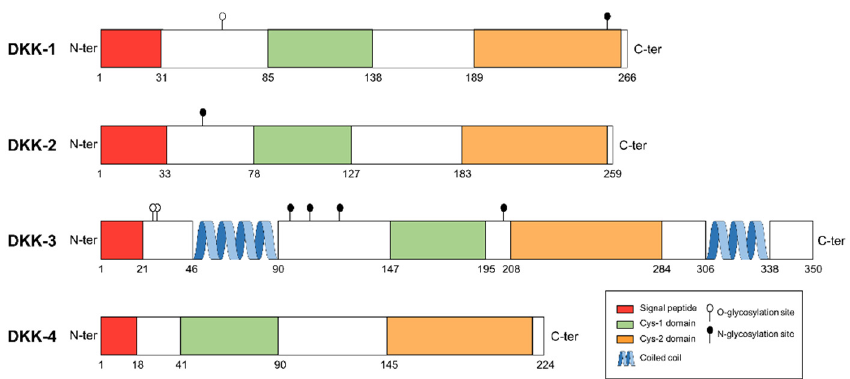
Figure 1. Domain structure of human DKK protein family. Cysteine-rich domain 1 (Cys1) and Cys2 domains are shared by the four members of DKK family. Signal peptide, coiled-coil region and glycosylation sites are also shown.